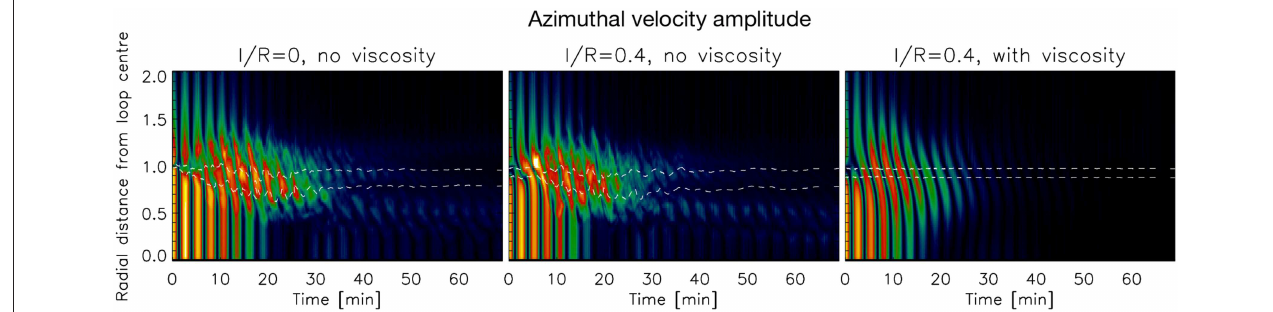
FIGURE 6 | Azimuthal velocity amplitude from the loop’s center. For each loop model, the azimuthal velocity amplitude (in absolute value) is calculated along moving ellipses around the loop’s center that evolve through time. The ellipses are self-similar and their semi-major to semi-minor axis ratio matches the ellipse fitting the edge of the loop at each time step. Hence, for each ellipse at a given radial distance from the loop’s center, we obtain an average value of the azimuthal velocity amplitude (in absolute value). The upper and lower dashed contours correspond, respectively, to the regions where the local Alfvén speed is 10% higher and 10% lower than the kink speed (see text for further details). From left to right the columns correspond, respectively, to the model with no initial boundary layer and no viscosity, the model with initial boundary layer and no viscosity, and the model with initial boundary layer and viscosity. Note that the color table has not been normalized to the same maximum between all loop